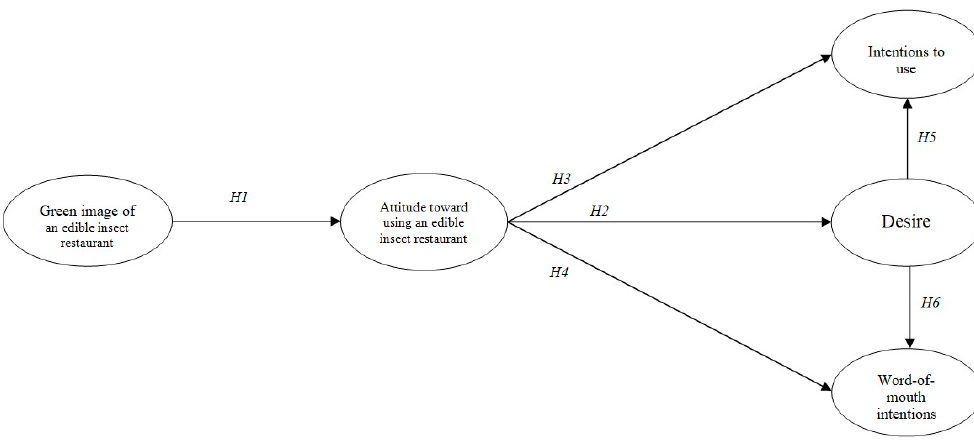
Figure 1. Proposed conceptual model.